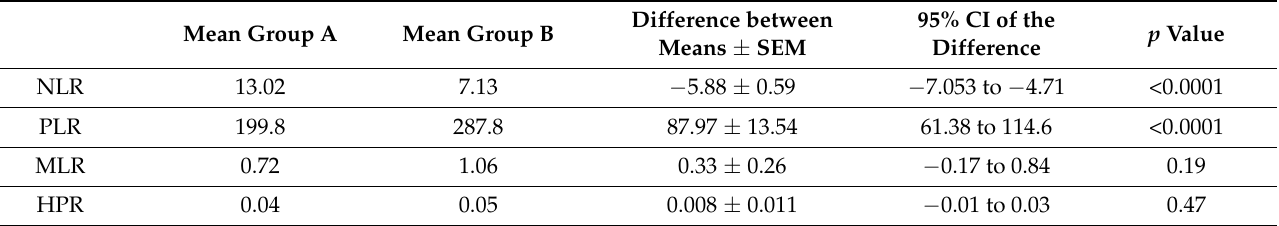
Table 2. Comparative analysis of the novel biomarkers.